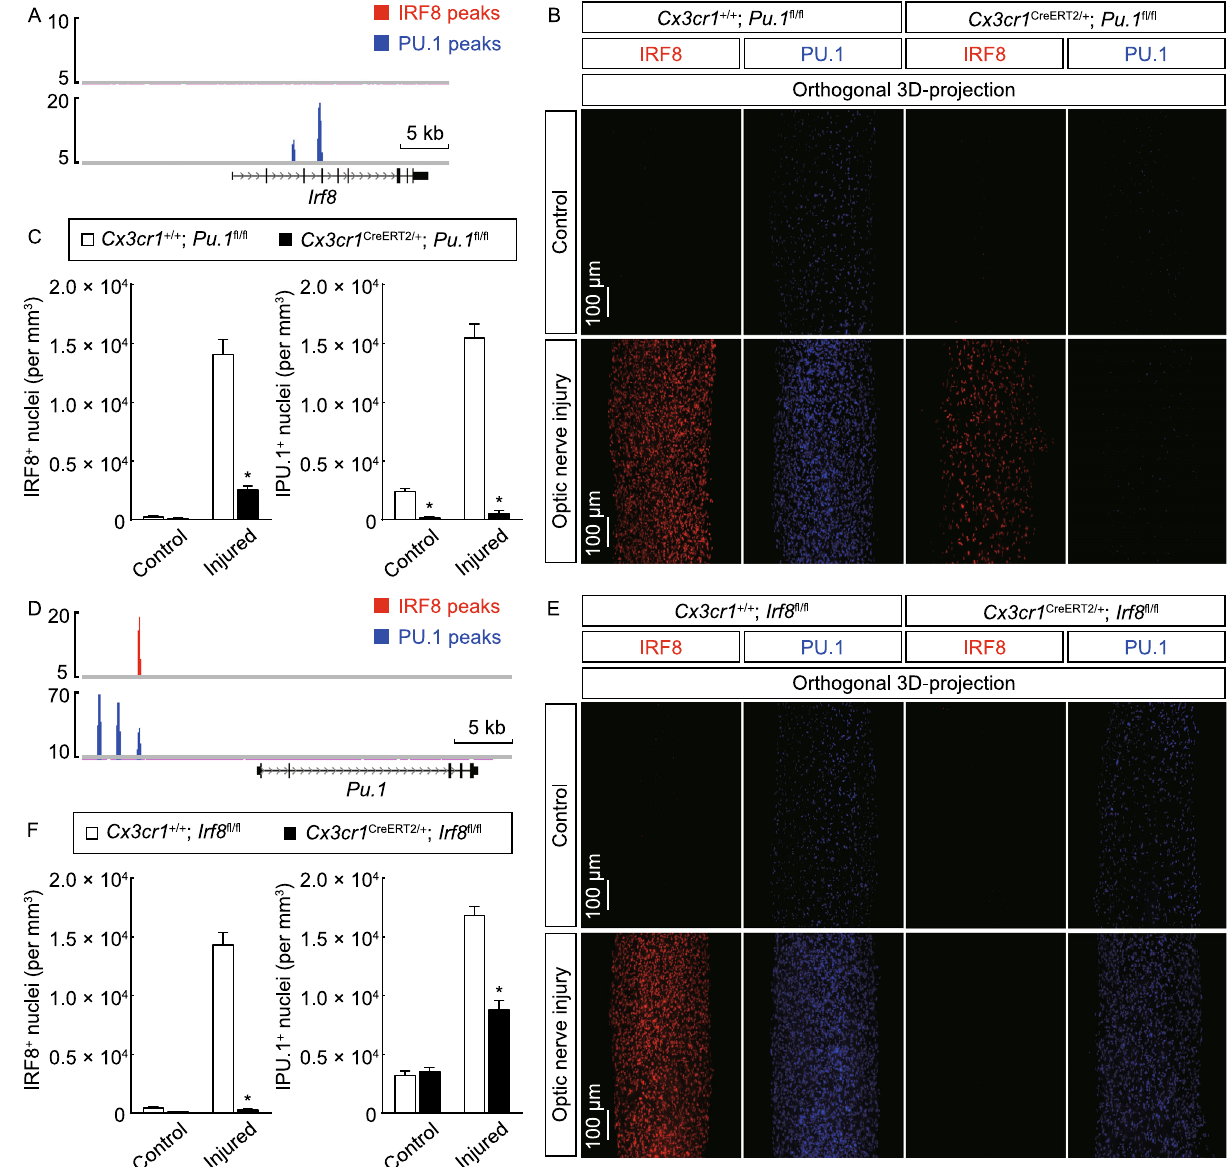
Figure 4. Cross-regulation of IRF8 and PU.1 in microglial activation. (A) PU.1 directly targets IRF8 expression in microglial activation. IRF8 and PU.1 target sites at the gene locus of Irf8 are shown. (B and C) PU.1 regulates IRF8 expression. Cx3cr1 +/+ ; Pu.1 fl / fl vs. Cx3cr1 CreERT2 /+ ; Pu.1 fl / fl mice were treated with 4-hydroxytamoxifen to induce the Cre-recombinase activity and